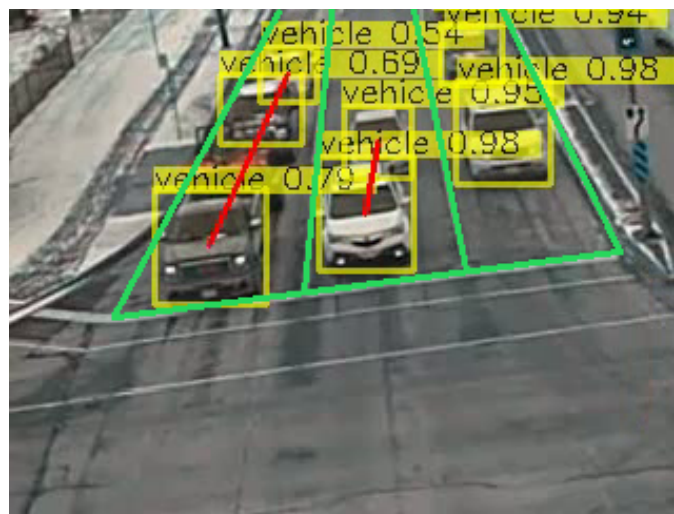
Figure 3. Queue length